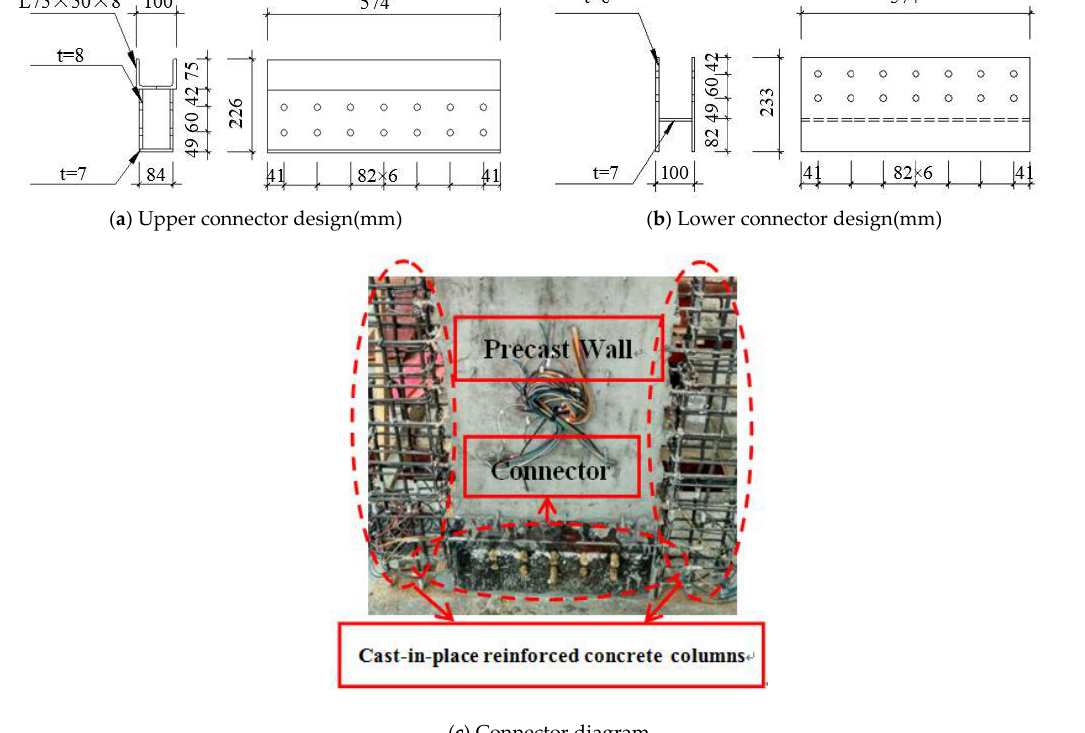
Figure 2. Connector design. Figure 2. Connector